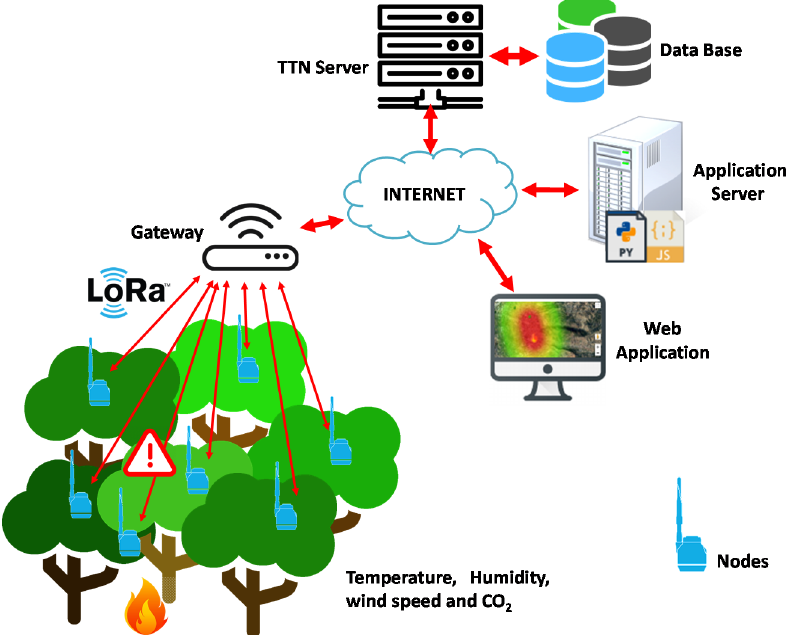
Figure 6. Network architecture of our proposal.